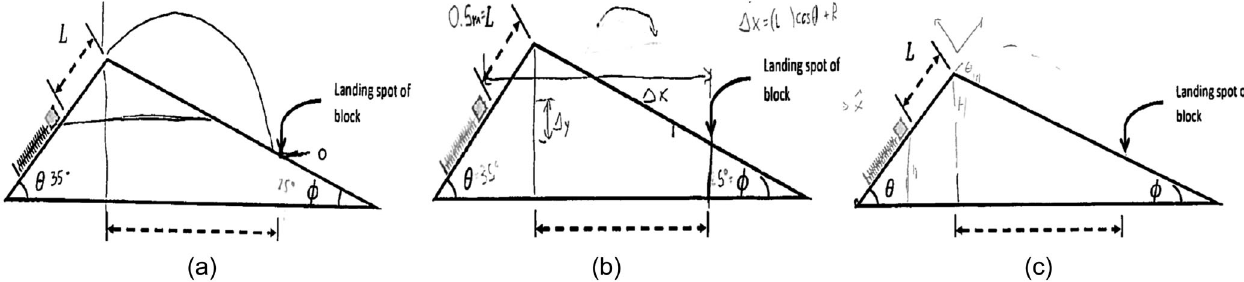
FIG. 8. Typical student responses for factors cueing energy conservation and